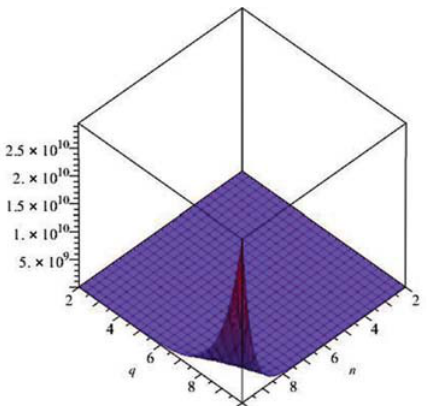
Figure 7: Plot of GA